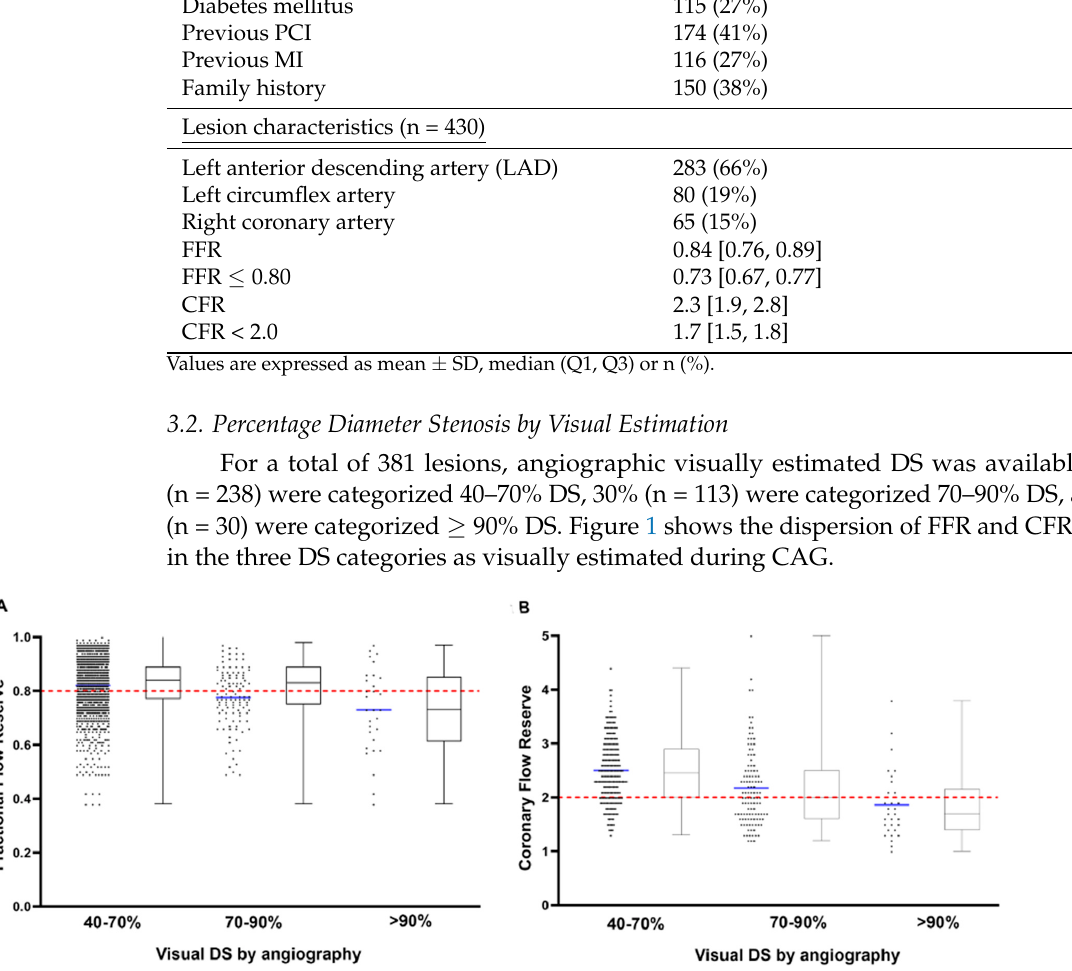
Figure 1. Box-and-whisker and scatter plots showing the FFR ( A ) and CFR ( B ) values of all lesions in the category of DS 50–70%, DS 70–90% and DS > 90% as determined by visual estimation during coronary angiography. The red dashed horizontal lines represent clinical cut-off values of FFR ( ≤ 0.80) and CFR (<2.0).